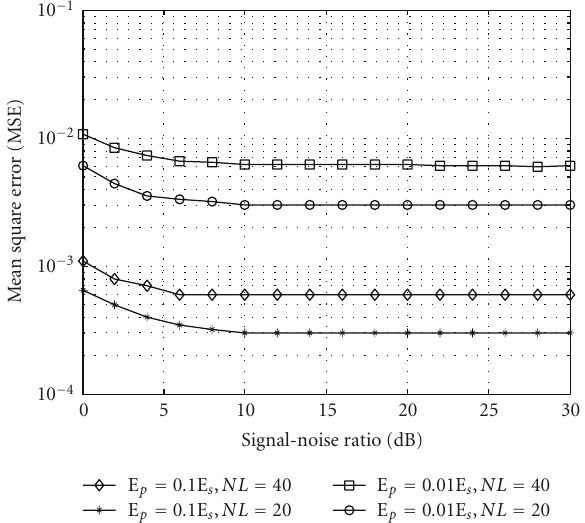
Figure 3: MSE versus SNR, with the LTV channel of f n = 300 Hz and Ω = 13 . 62 milliseconds under the di ff erent IPR and system unknowns